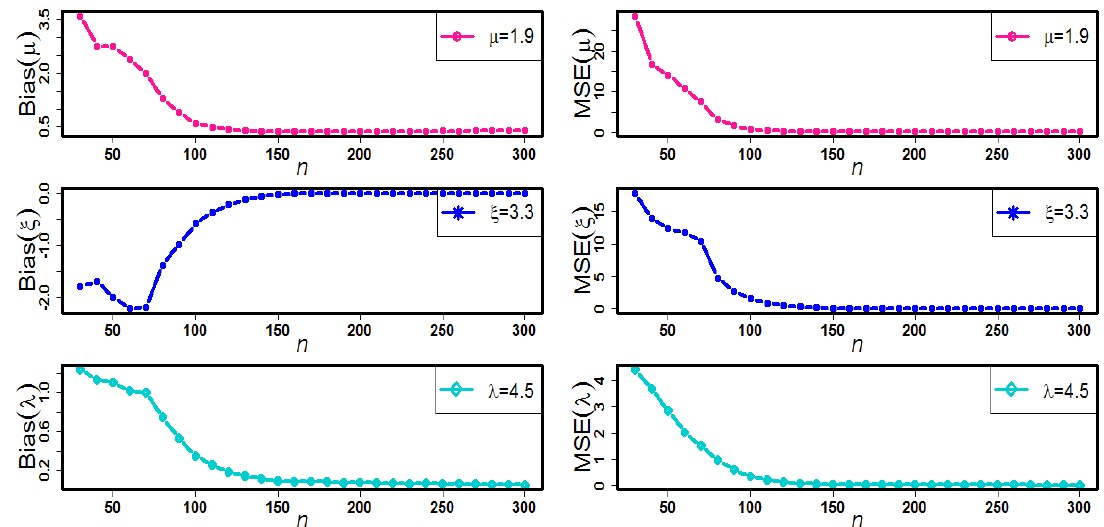
Fig. 6. The performance of Bias and MSE pro(cid:133)les against (cid:20) (cid:22); (cid:20) (cid:24) and (cid:20) (cid:21) for set-III : Figure 6. The performance of bias and MSE profiles against ˇ µ , ˇ ξ and ˇ λ for